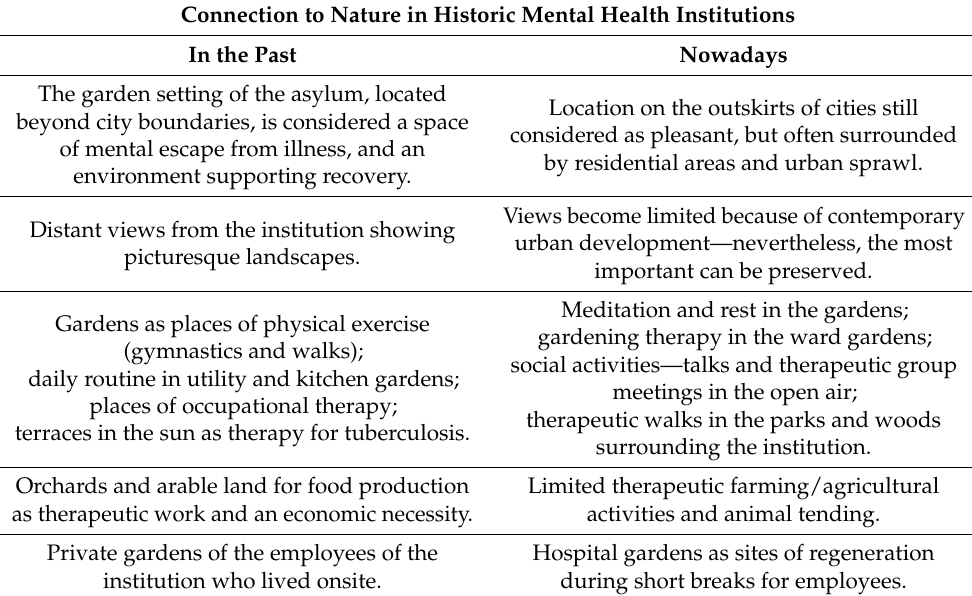
Table 2. Comparison of the types of connections to nature and gardens in historic mental hospitals in the past and nowadays; source: author’s elaboration.